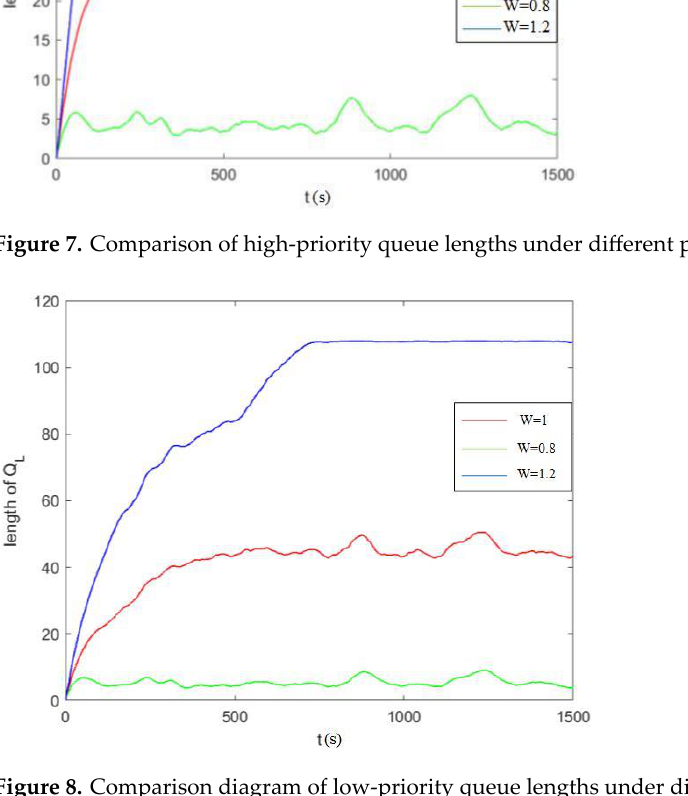
Figure 8. Comparison diagram of low-priority queue lengths under different packet arrival rates.